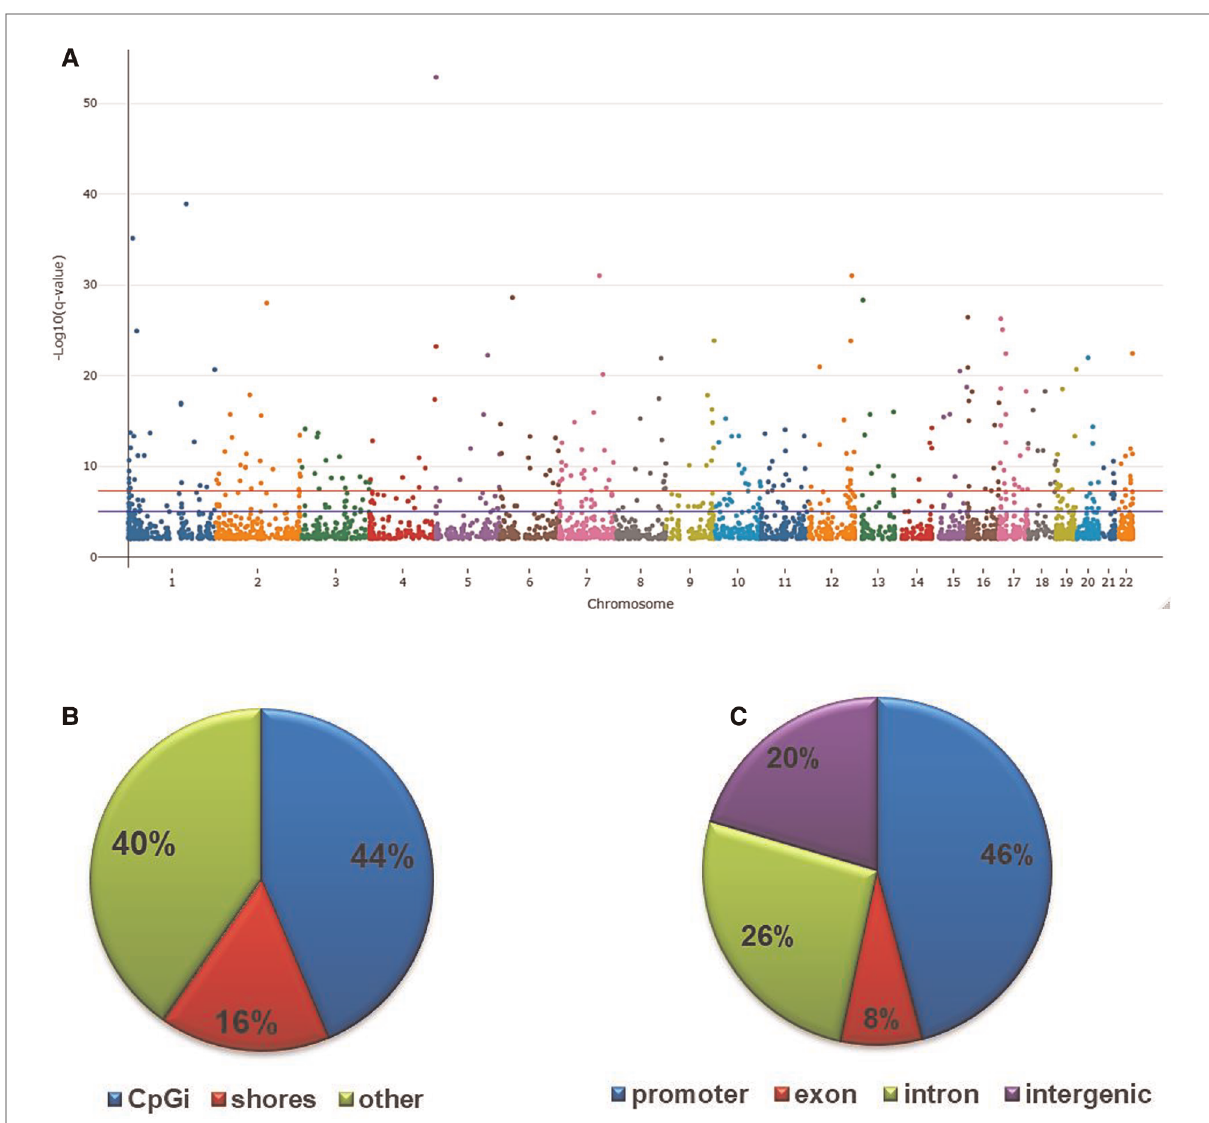
FIGURE 2 Genomic distribution of differentially methylated CpGs in low vs. high stigma in adults with non-speci fi c cLBP. ( A ) The Manhattan plot dispicting the distribution of the CpGs on the autosome. The red line indicates the genome wide signi fi cant threshold − log10(5×10 − 08 ); blue line is the suggestive line. ( B ) Fraction of CpGs differentially methylated relative to CpG distribution on the reference genome: CpG island (44%), CpG shores (16%) and others (40%). ( C ) Fraction of CpGs differentially methylated based on their distribution on various annotated genes: promoter (46%), introns (26%), exons (8%) and intergenic regions (20%). All depicted CpGs were signi fi cantly differentially methylated between individuals with low vs. high stigma ( q